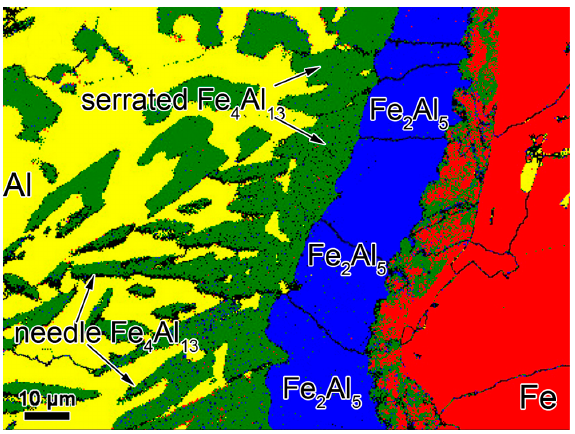
Figure 9. EBSD phase mappings of the interface of Al/steel joints at a laser beam offset of 0.3 mm. Table 2. Intermetallic compound (IMC) phases identified using electron back-scattered diffraction (EBSD) phase